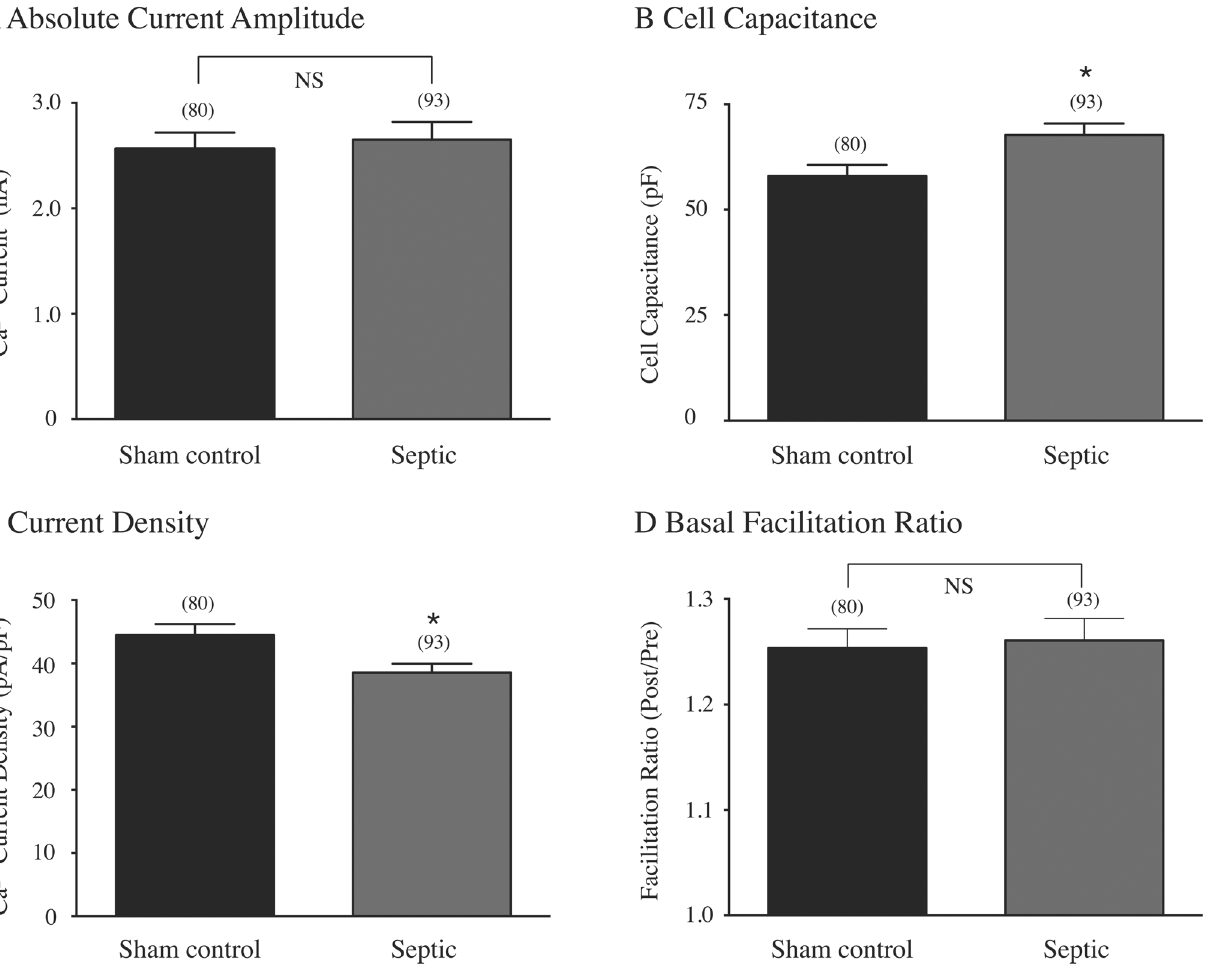
Fig 2. Biophysical properties of CSMG neurons from sham control and septic rats. Measurement of the mean absolute Ca 2+ current amplitude (A) at the depolarizing potential to +10 mV. Ca 2+ current density (B) was calculated from the peak Ca 2+ current amplitude at the test pulse of +10 mV and normalized to membrane capacitance. The cell membrane capacitance (C) was determined from the numerical integration of a transient elicited with a depolarizing pulse from -80 mV to -70 mV prior to electronic compensation. Summary graph of the basal facilitation ratio (D), calculated as the ratio of Ca 2+ current amplitude determined from the test pulse (+10 mV) occurring after (postpulse) and before (prepulse) the +80 mV conditioning pulse (see Fig 3A, top right). The current amplitude was measured isochronally 10 ms after initiation of the test pulse. The numbers in parenthesis indicate the number of neurons tested; * indicates P < 0.05, unpaired t -test, NS indicates not significantly different, P > 0.05.